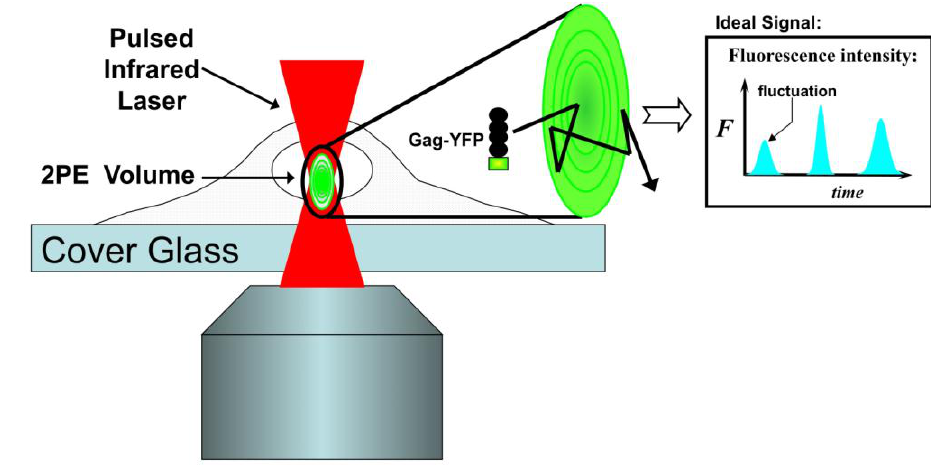
Figure 3. Fluorescence Fluctuation Spectroscopy (FFS). FFS monitors the fluorescence of single molecules moving through a laser excitation region. In FFS using two-photon excitation (2PE) a pulsed infrared laser is used to create a small excitation region (~1/1000 th the volume of a cell) in the sample. The fluorophore is only excited in the focal region of the beam, as explained in the text. A single Gag-YFP molecule which either diffuses or is transported through the focal volume (inset) causes a burst in detected fluorescent intensity. By monitoring the characteristic timescale, amplitude, and frequency of the fluorescent fluctuations caused by single molecules moving through the focus, one can obtain information relating to protein mobility (duration of fluctuations), protein stoichiometry (amplitude of fluctuations), and concentration (frequency of